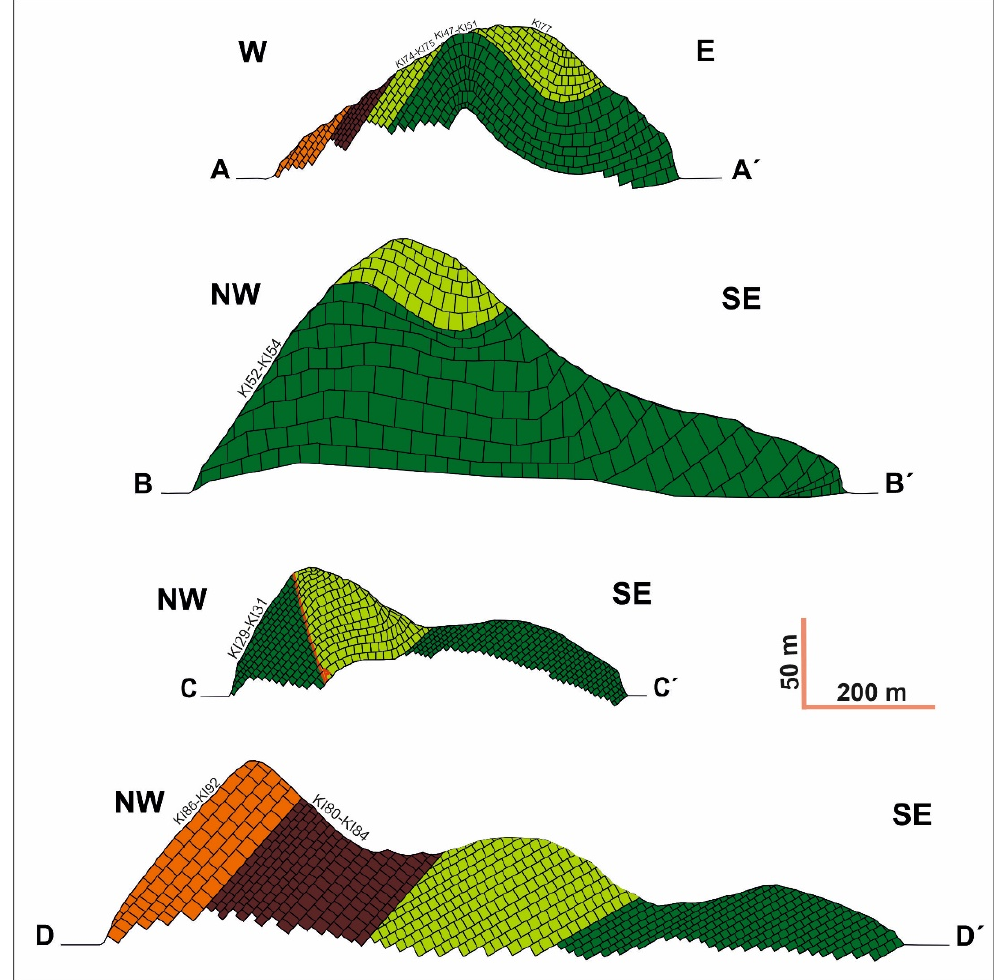
Figure 9. Four cross-sections show the present-day situation, from NE to SW on Kastos Island. For the location of cross-sections, see Figure 8.